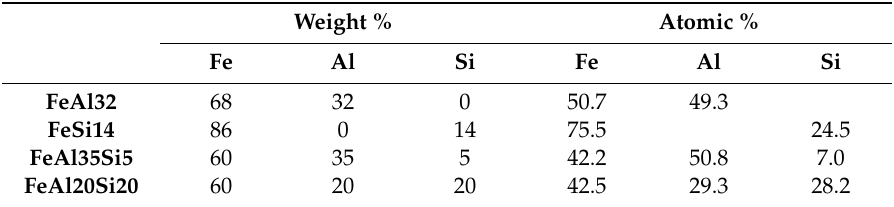
Table 1. Nominal chemical composition of the tested